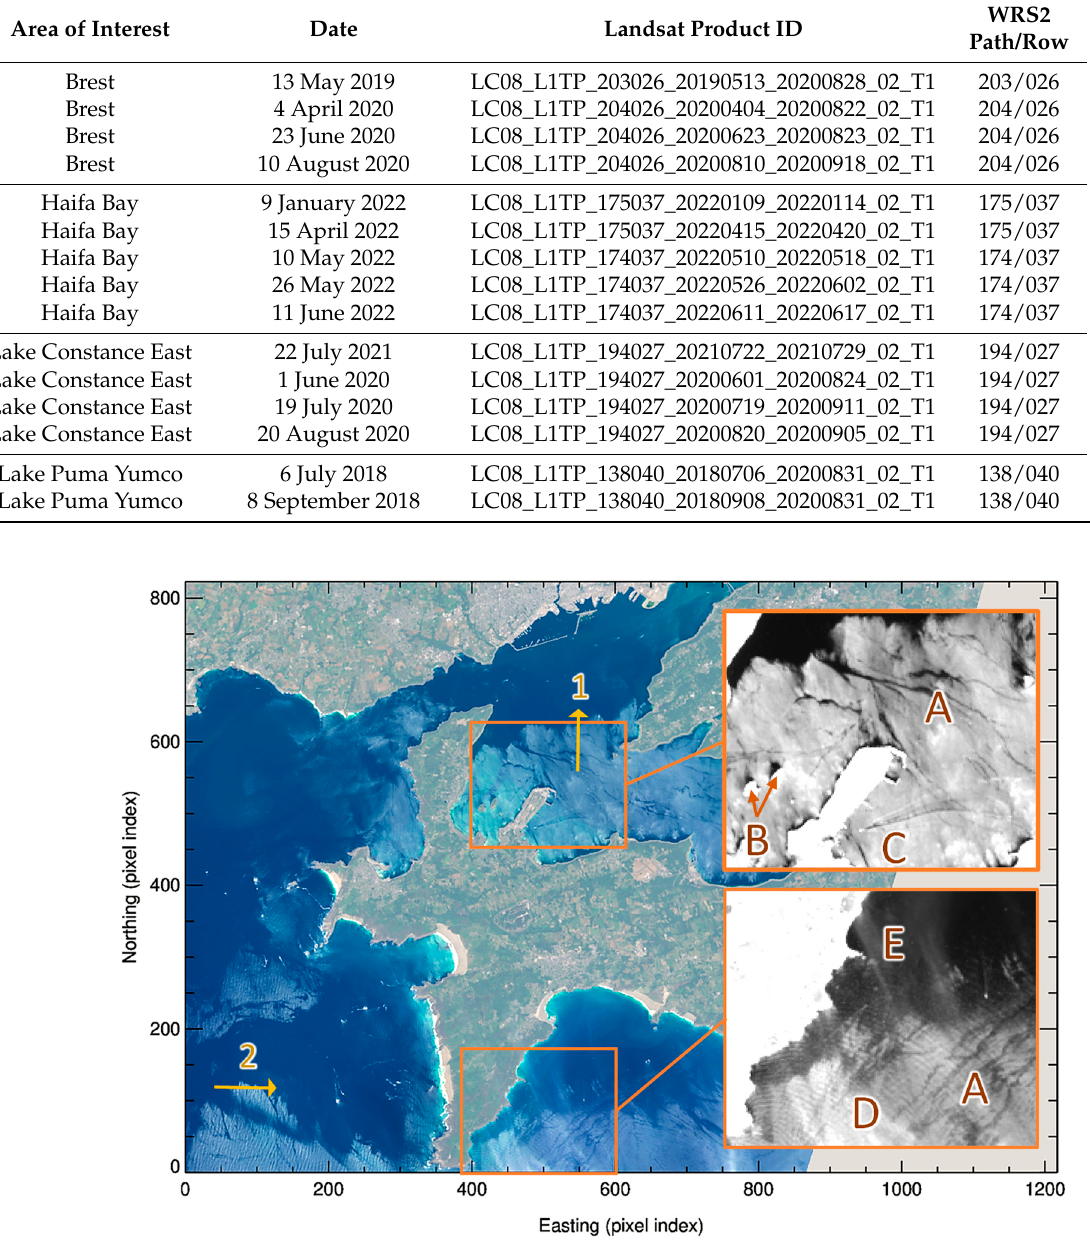
Figure 1. Contrast-enhanced near-true-color image derived from sample scene BRS-3, using OLI channels B2, B3, and B4. The two yellow lines labeled “1” and “2” indicate the transects analyzed in Figure 2. The insets on the right show the shortwave infrared (SWIR) reflectance in channel B7 for two subareas with the letters “A” to “E” pointing to characteristic glint reflectance patterns. See text for further explanation.